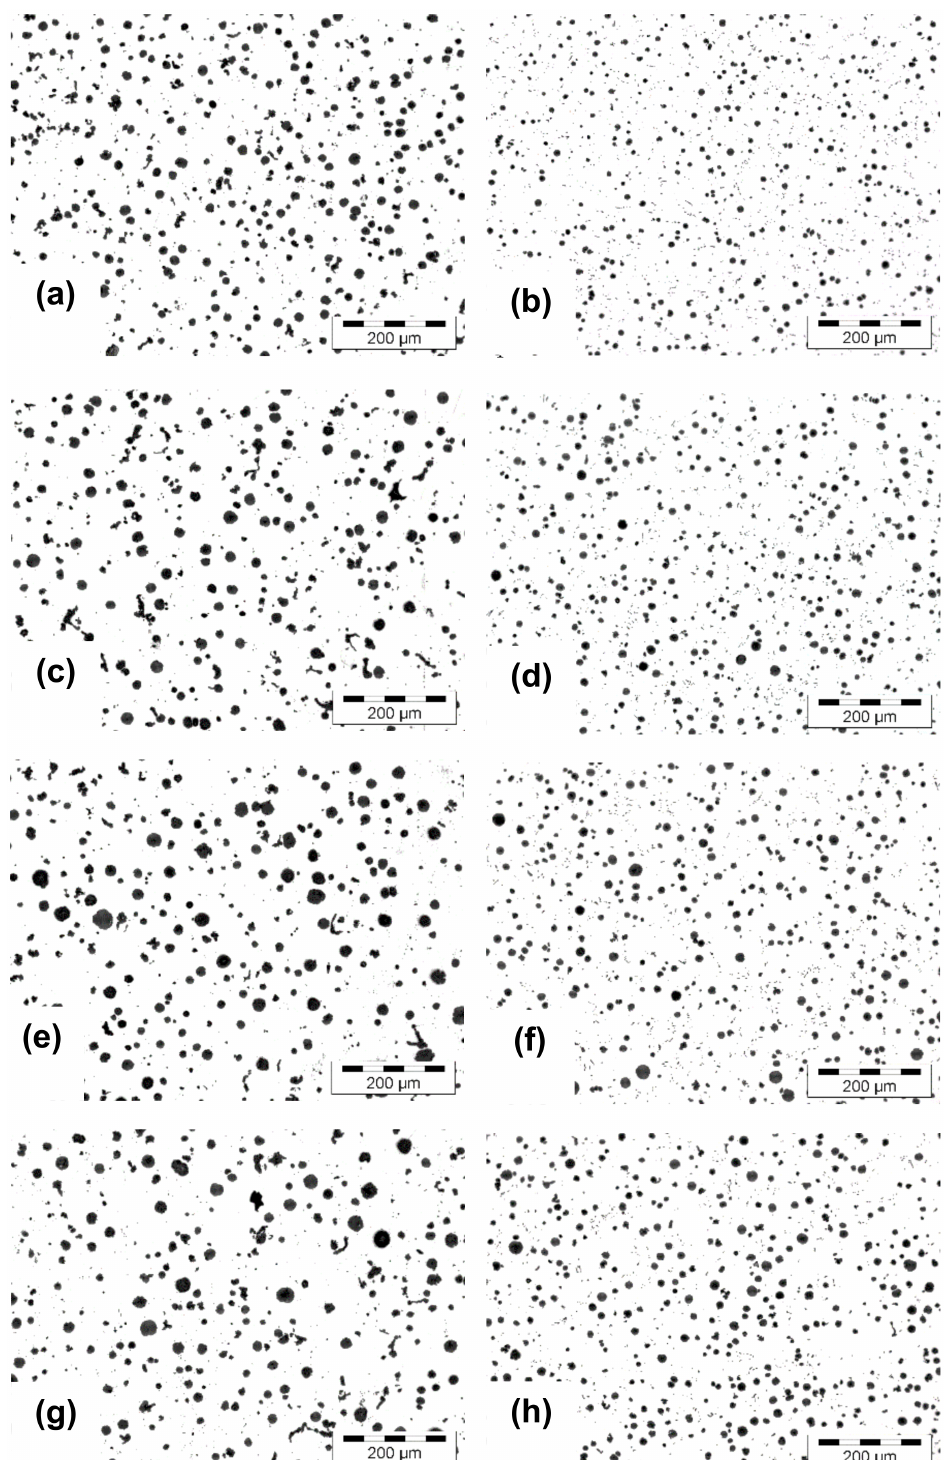
Figure 1. Structure of 4.5% Si ductile iron solidified in wedge casting in a green sand mold ( a , c , e , g ) and metal mold ( b , d , f , h ) with different wall thicknesses: (( a , b ) 6 mm; ( c , d ) 9 mm; ( e , f ) 12 mm; ( g , h ) 15 mm)